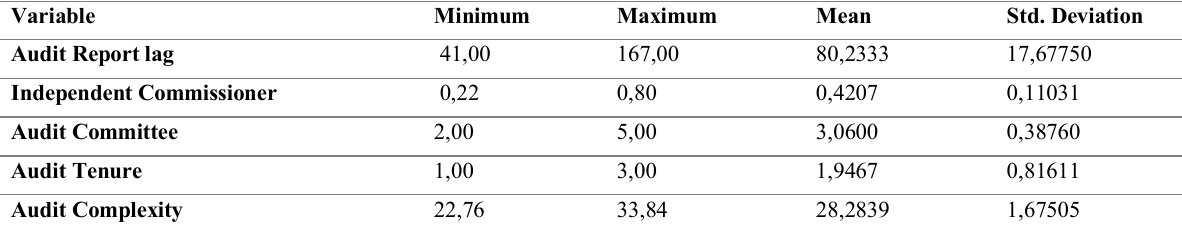
Table 1: Descriptive Statistics